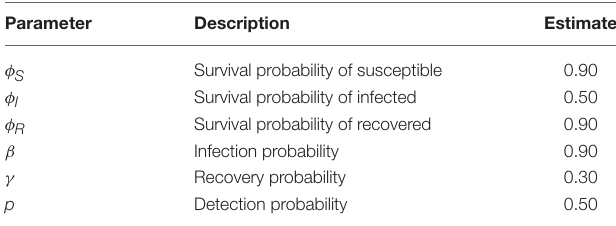
FIGURE 2 | Schematic representation of the SIR dynamics with state uncertainty between two sampling occasions, t and t + 1. The state or biological process (left) and the observation process (right) underlie the construction of the MECMR model. In the state process [corresponding to the matrix SIR_Model , Equation (1)], solid circles indicate infection states (S [blue]: “susceptible”, I [orange]: “infected,” R [green]: “recovered”) and the dead state (D, [black]). The solid black arrows indicate transition probabilities between those states as a function of the probability of surviving in a given state ( φ i , with i specific for S, I and R), i.e. the probability of staying susceptible (1 – β ), becoming infected ( β ), staying infected (1- γ ) or recovering ( γ ). The observation process was composed of two steps: detection of individuals [corresponding to the matrix Obs1 , Equation (2)], and assignment of infection states [corresponding to the matrix Obs2 , Equation (3)]. Events are shown in black solid boxes. Solid gray arrows indicate the detection probability of individuals in a given state ( p j with j being specific for S, I, and R) and the assignment probability of individuals in a given state ( δ k with k being specific for S, I and R). disease already started spreading at the beginning of the study. TABLE 1 | Fictive input parameter values for the probabilities of surviving ( φ ), becoming infected ( β ), recovering ( γ ) and of detection ( p ), which were used to simulate data